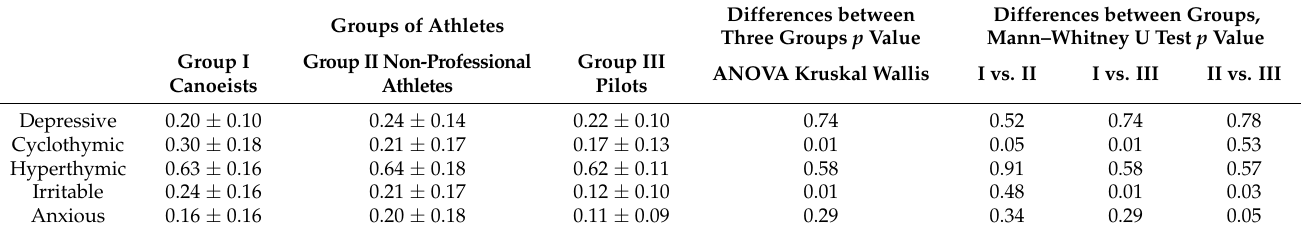
Table 4. The results of TEMPS—A in three groups of athletes studied. Mean values ± SD, differences between groups.